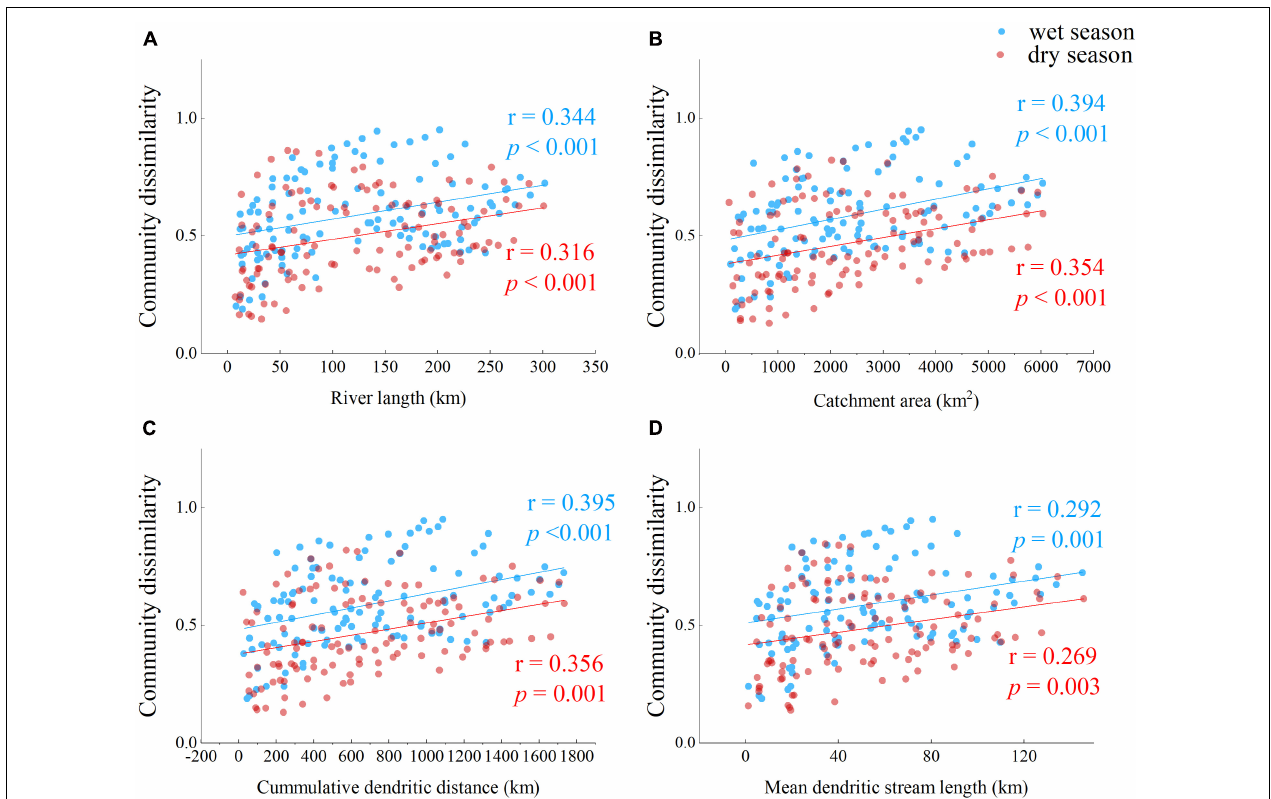
FIGURE 6 | Bray–Curtis dissimilarity values of bacterioplankton communities in response to four geographic distance parameters. Relationships are shown between (A) river length (km), (B) catchment area (km 2 ), (C) cumulative dendritic distance (km), and (D) mean dendritic stream length (km) with Bray–Curtis dissimilarity values for bacterioplankton communities. Pearson correlations ( r ) and probabilities ( p ) are shown to the right of each plot. TABLE 1 | Correlations between different combinations of environmental factors and bacterioplankton communities, as indicated by Bioenv analysis. Combination in wet season Correlation Combination in dry season Correlation Water